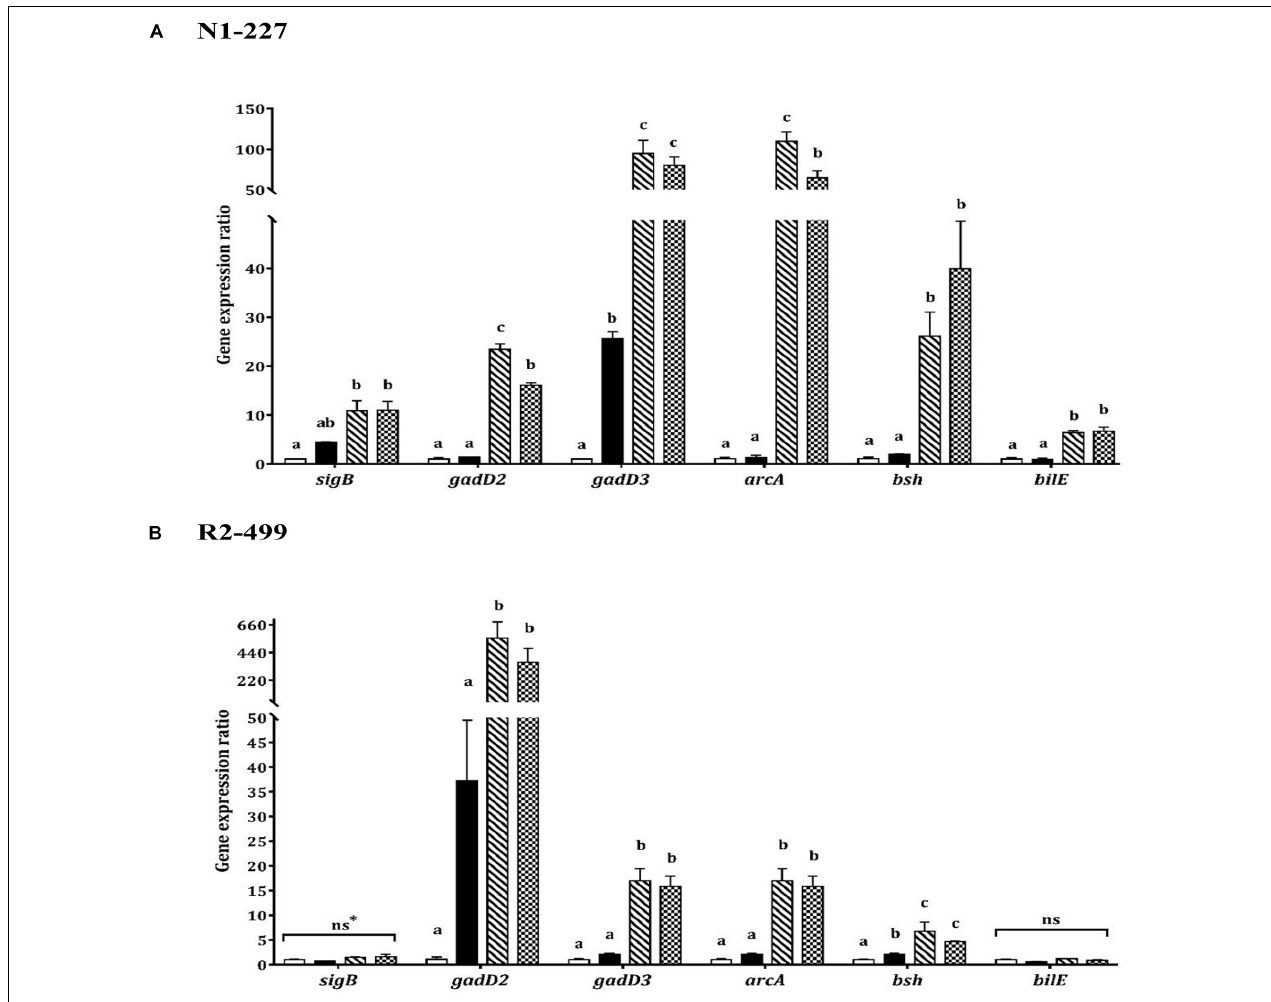
FIGURE 2 | Relative gene expression of acid and bile stress response related genes in 20 min habituated Listeria monocytogenes strains (A) N1-227 and (B) R2-499 cells in comparison with non-habituated cells (baseline control, TSB pH 7.4, ), TSB at pH 6.0 with 4.75 mM of acetic acid ( ) and TSB at pH 6.0 with 4.75 mM of L-lactic acid ( ). Error bars represent standard error of mean for two biological trials with three replicates for each trial. Different letters indicate that treatments are significantly different ( p < 0.05) as determined by one-way ANOVA with